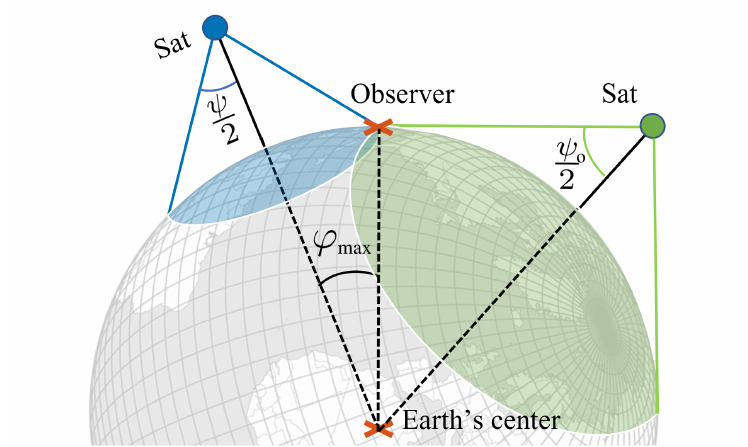
Figure 4. Illustration of the satellite footprint, whereby the blue patch represents the footprint when limited by the satellite antenna beamwidth, ψ , and the green patch represents the maximum satellite footprint limited by the Earth’s occlusion, i.e., horizon-limited, ψ o .